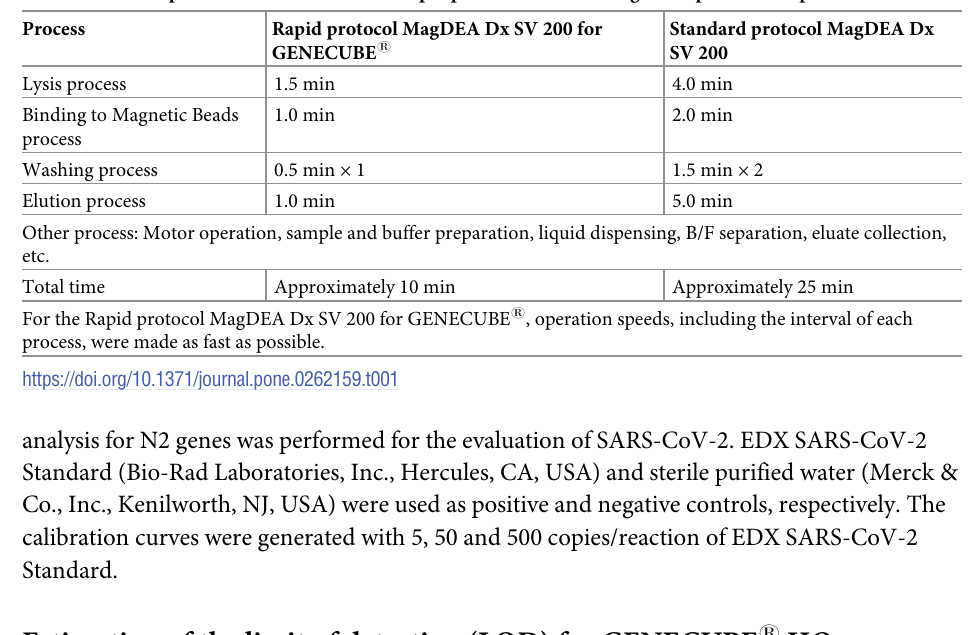
Table 1. The comparison of the standard and rapid protocols for each magLEAD purification